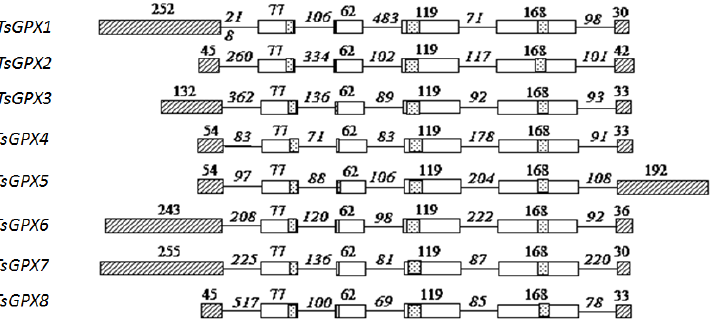
Figure 1. Intron-exon organization of the eight TsGPX genes. The box represents exon, and the line represents intron. Dotted boxes show conserved domains, and slashed boxes represent exon 1 and exon 6. The numbers represent the length of the corresponding exon or